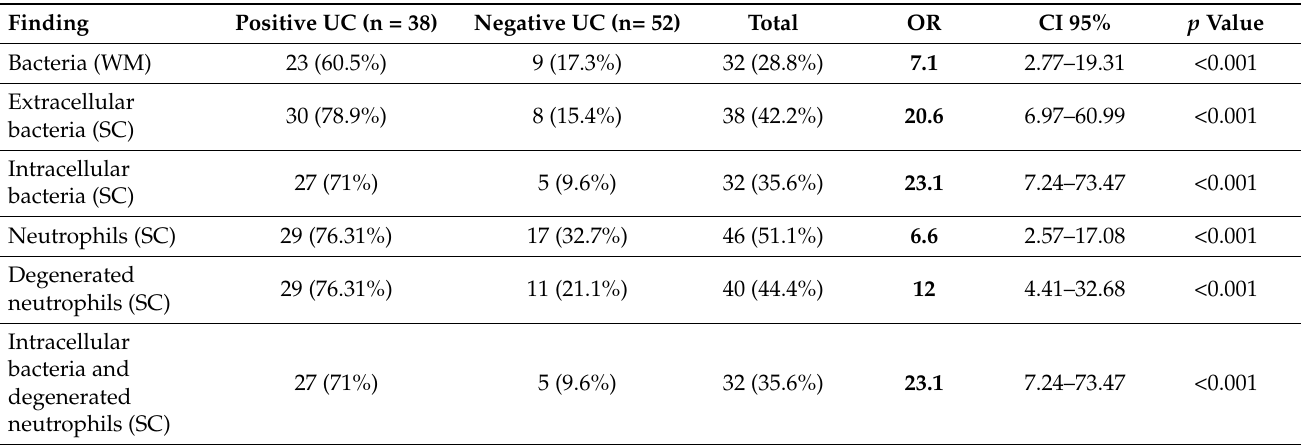
Table 3. Association between wet-mount and stained cytologic findings with positive urine culture outcome.